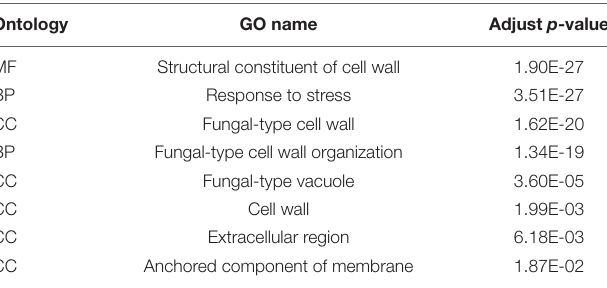
TABLE 3 | Significantly enriched GO terms in Cluster